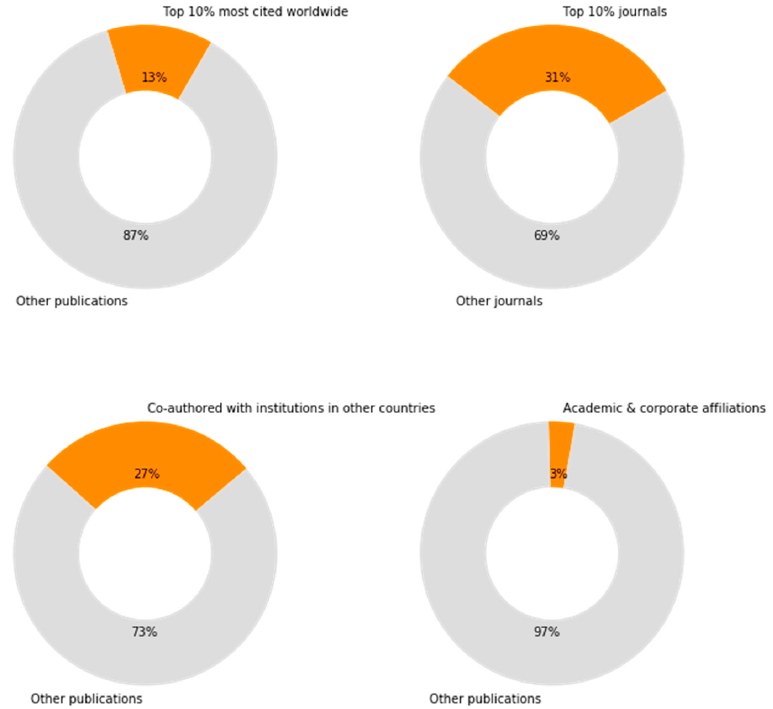
Figure 3. Performance indicators within renewable energy, sustainability and the environment, 2020–2021 (Based on the SciVal database (www.scival.com, accessed on 7 April 2021); data source: Scopus (downloaded on 7 April 2021); copyright: Elsevier B.V.).